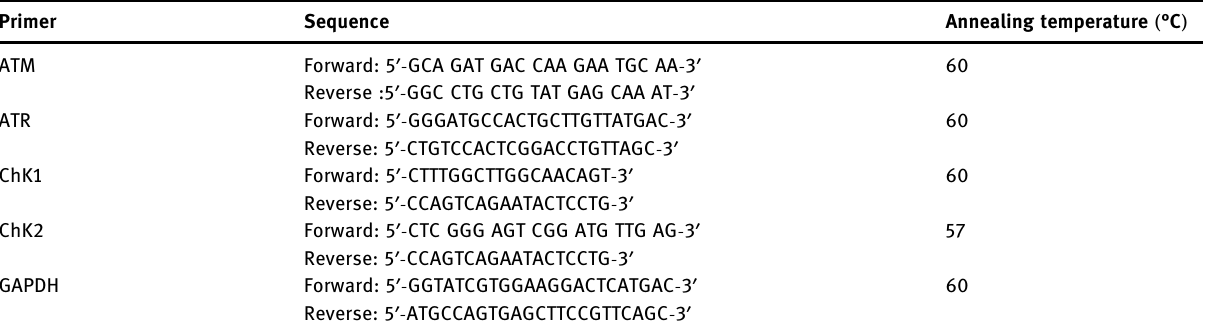
Table 1: Primer sequences of ATM, ATR, ChK1, CHK2, and GAPDH Primer Sequence